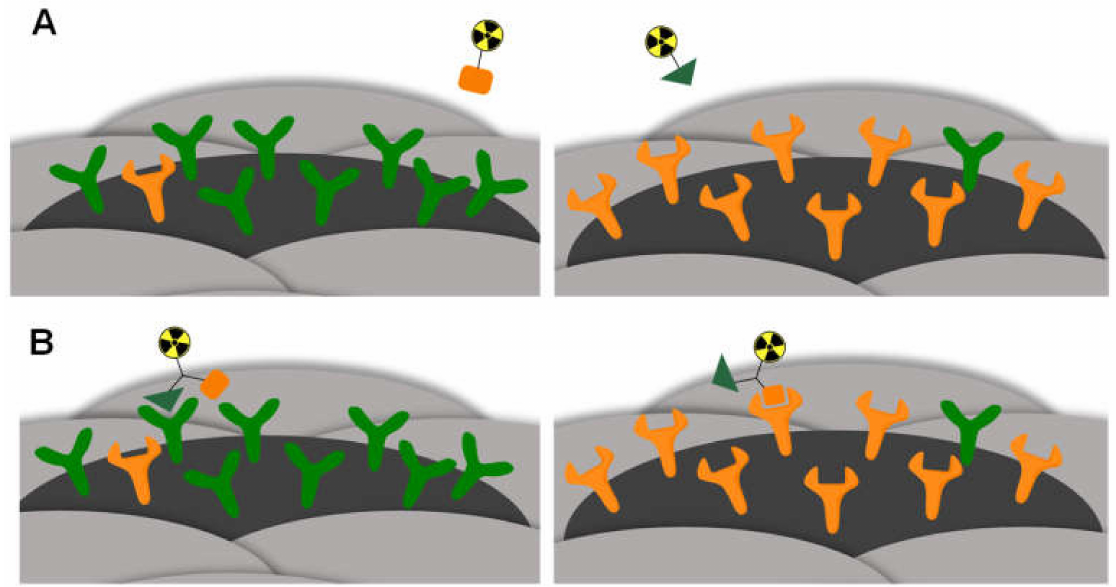
Figure 1. Schematic depiction of the concept of HBPL application exemplified by a comparison of a radiolabeled monospe- cific ( A ) or heterobivalent peptidic ligand ( B ) binding to tumor entities overexpressing different receptor types. In the case of ( A ), no binding is possible since the respective target receptor is only expressed to a low extent. In the case of ( B ), the HBPL can bind since at least one of the target receptors is expressed on the tumor